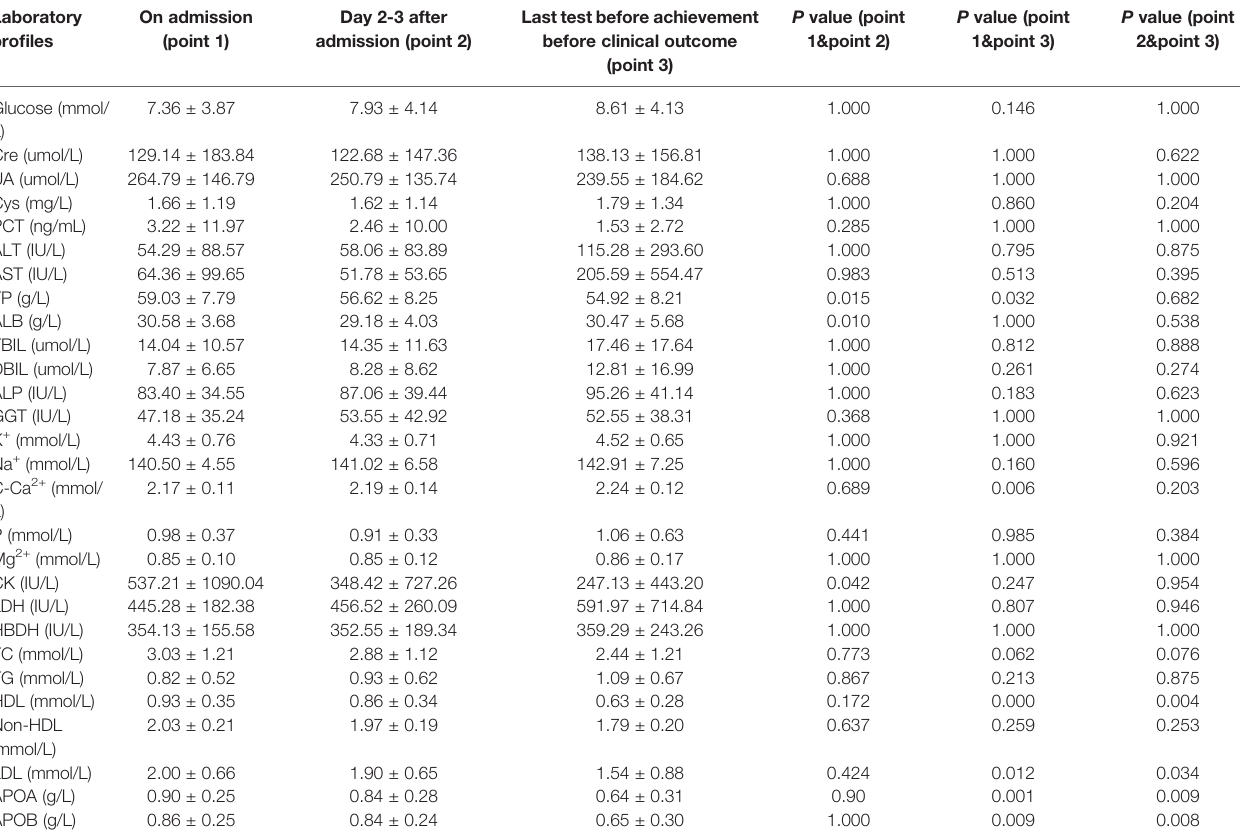
TABLE 2 | Main clinical laboratory tests of critical patients with COVID-19. Laboratory pro fi les